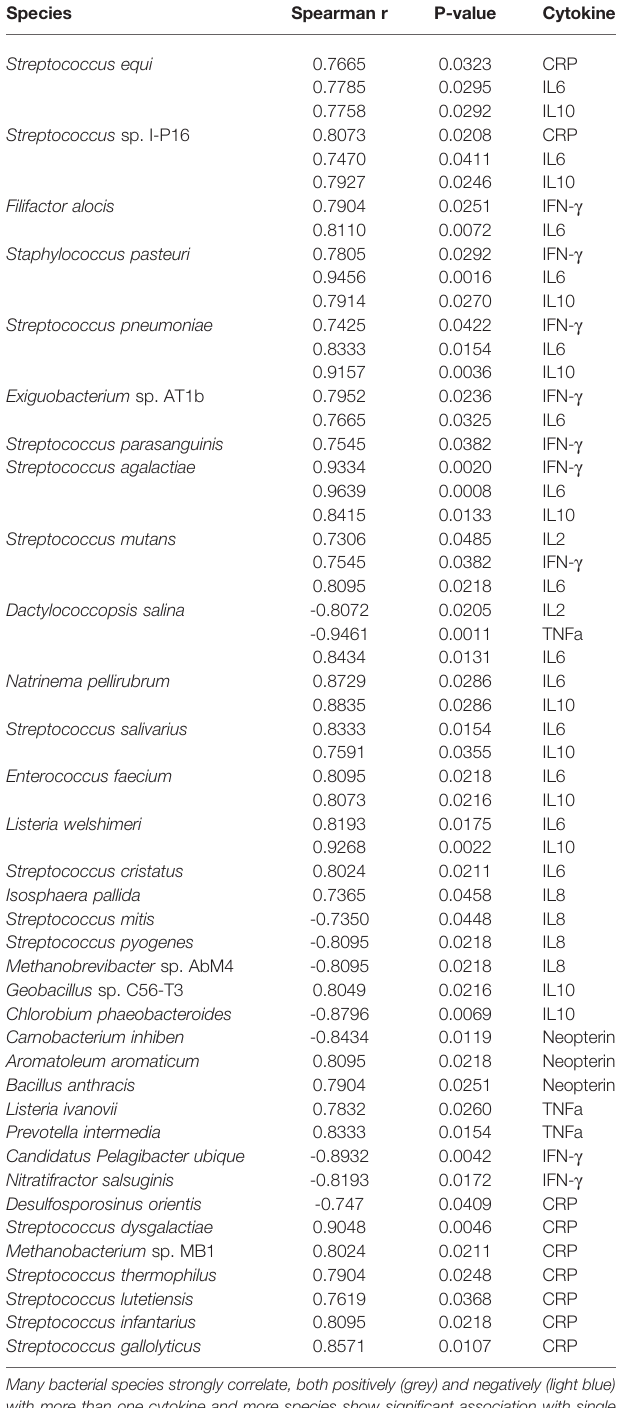
TABLE 1 | Correlation modeling of plasma cytokine levels with 100 signi fi cantly changing microbial species in geriatric animals compared to young adult. Species